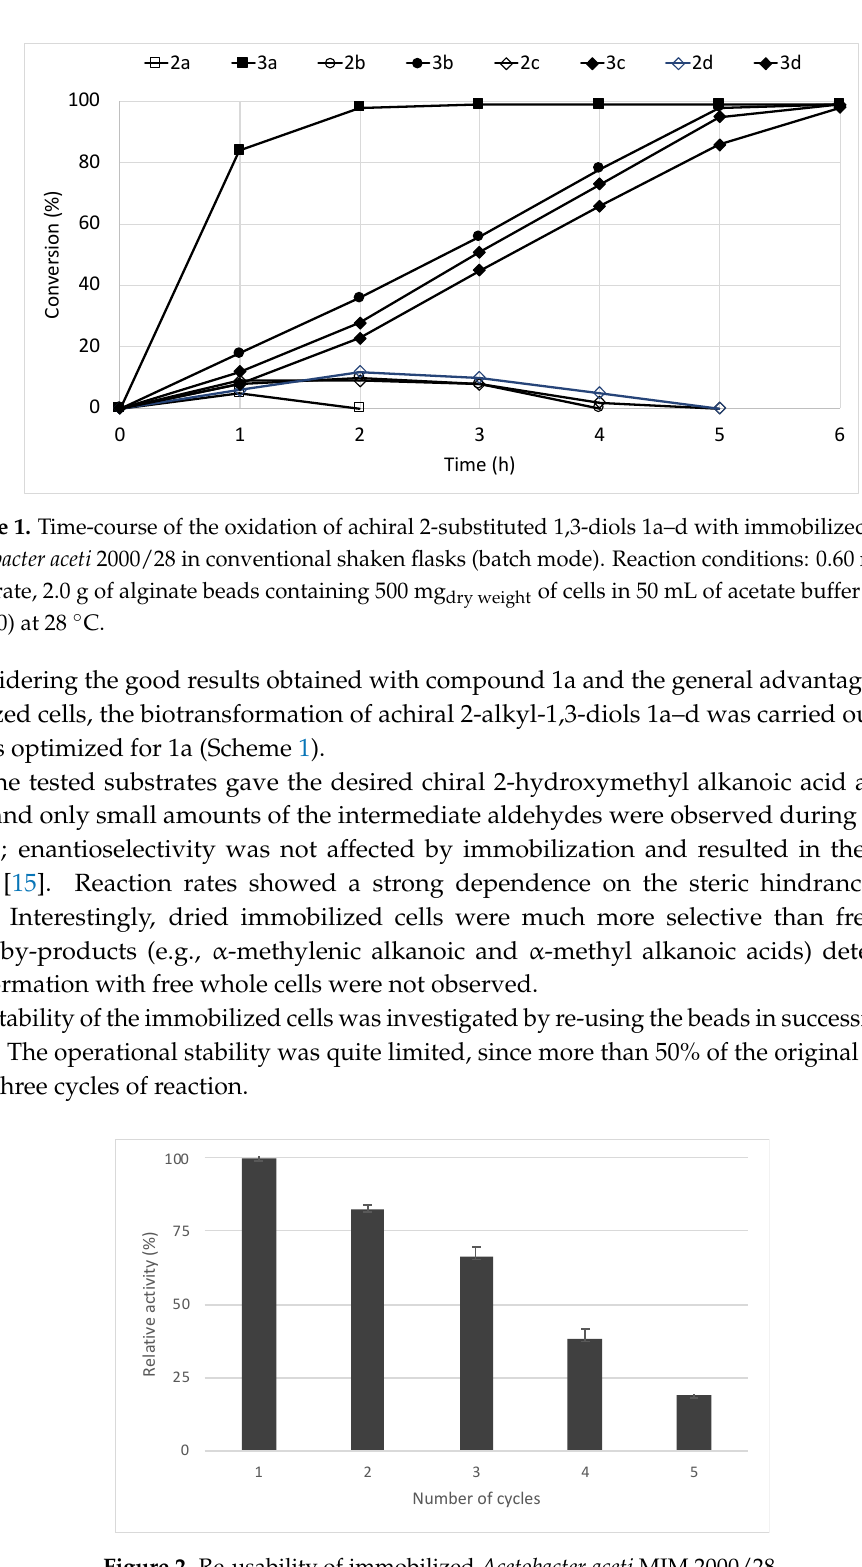
Figure 2. Re-usability of immobilized Acetobacter aceti MIM 2000/28.